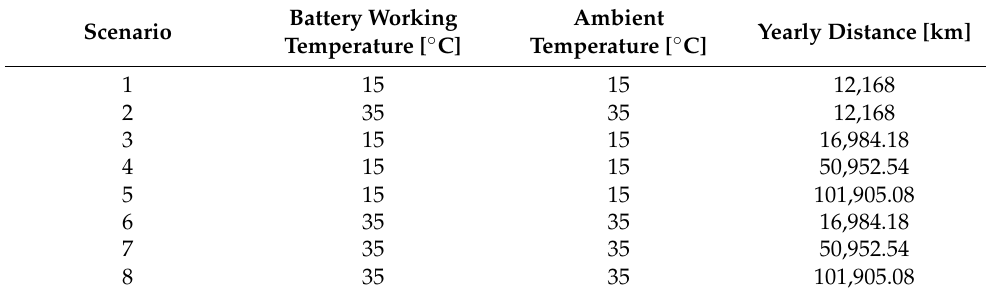
Table 14. Annual vehicle use scenarios.